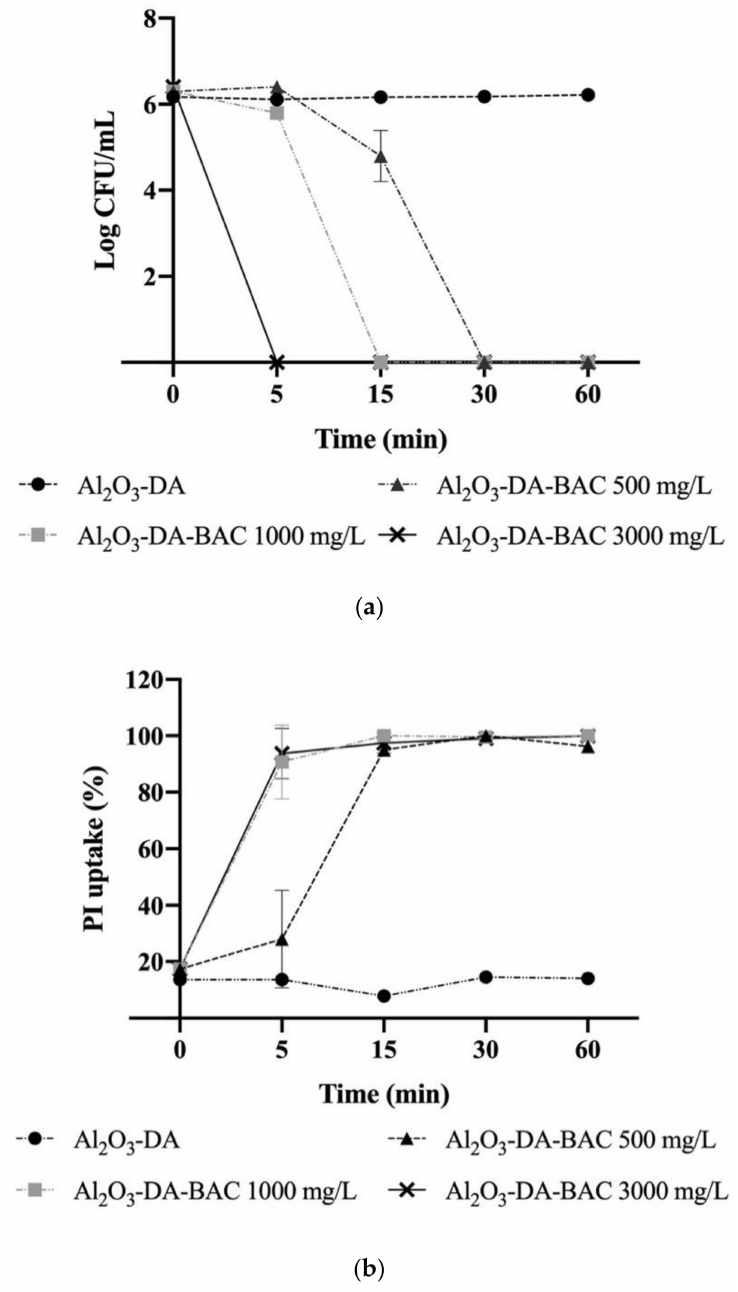
Figure 6. Logarithm of the colony forming units per milliliter (CFU/mL) ( a ) and propidium iodide (PI) uptake (%) ( b ) of Escherichia coli planktonic cells exposed to dopamine (DA)-functionalized particles over time during the first use. The overall tested concentrations were: 500, 1000 and 3000 mg/L. of Al 2 O 3, and Al 2 O 3 -DA particles were used as controls. Error bars correspond to the standard deviation of the mean determined for two independent